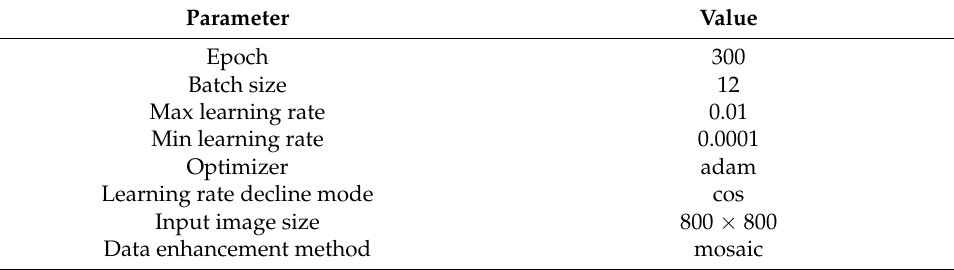
Table 3. Training parameter